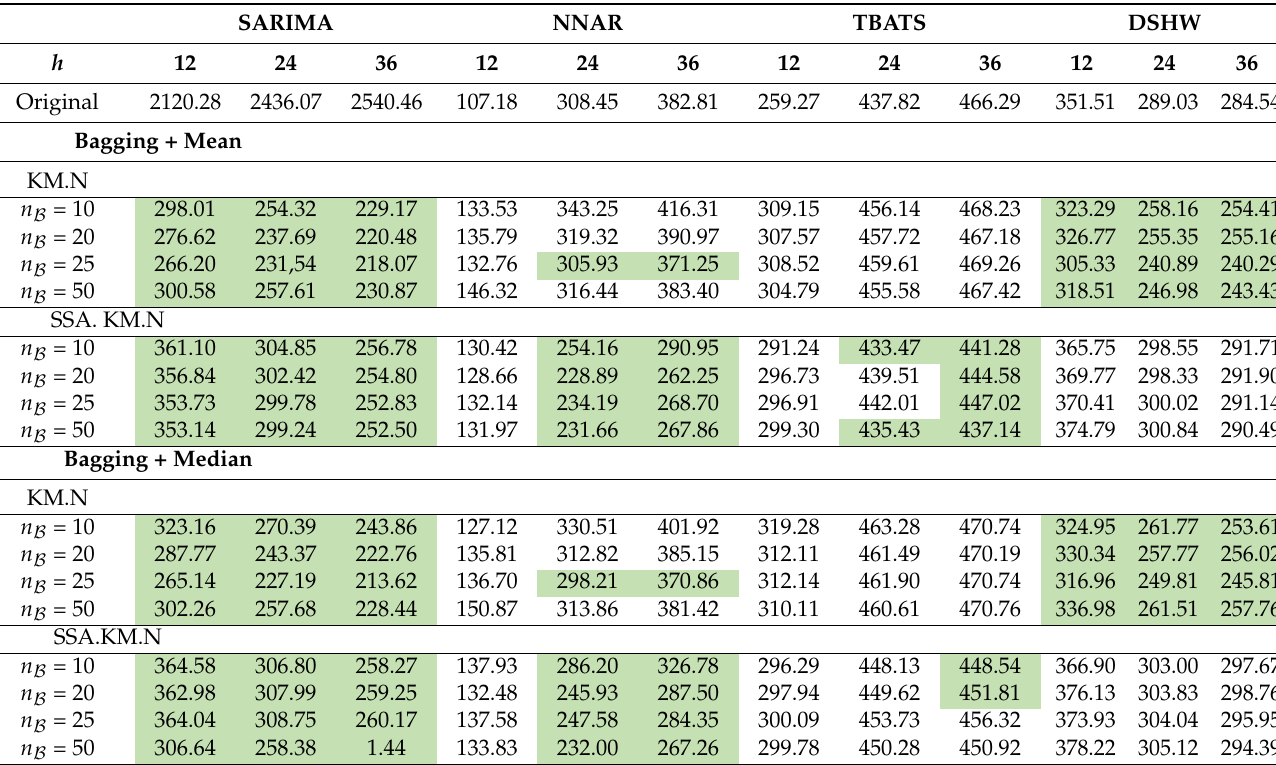
Figure 5. The hourly electricity load of Poland between 26 October and 16 December 2020. Table 9. RMSEs of h -step ahead forecast for the hourly electricity load of Poland obtained by SARIMA, NNAR, TBATS, and DSHW